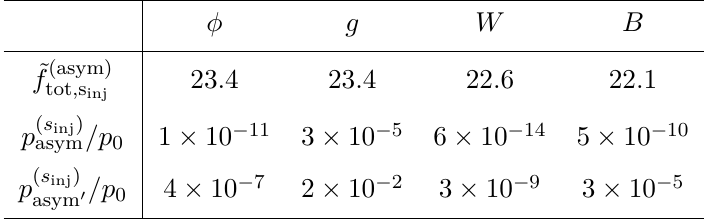
Table 3 . Same as table 1 but for s inj = ( φ, g, W, B )